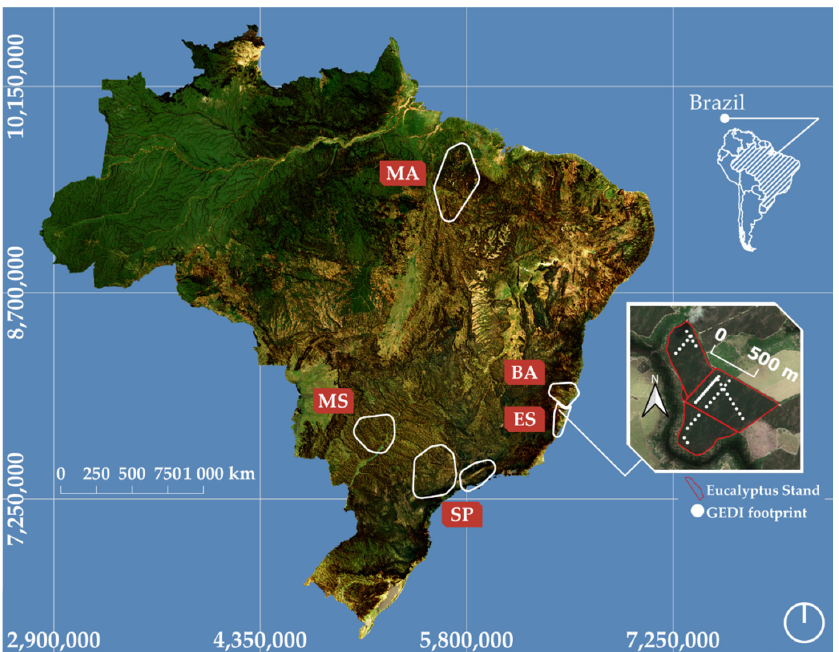
Figure 1. Location of the five study sites; the zoomed-in rectangle shows an example of GEDI tracks over some stands.